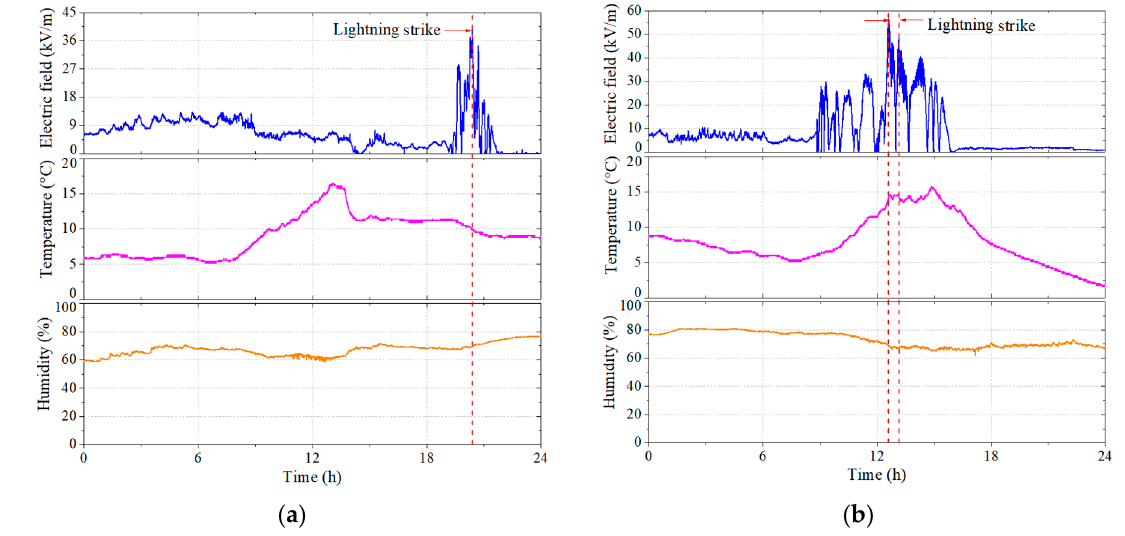
Figure 7. Electric field, temperature, humidity, and lightning data acquisition. ( a ) Case 1; ( b ) Case 2.